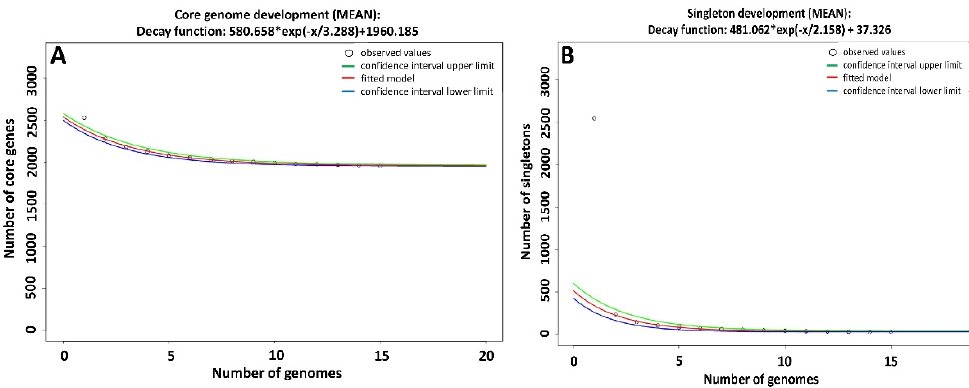
Figure 2. Singleton and Core-genome development plots calculated based on at least 15 representative D. congolensis genomes and a reference genome. It predicts that ( A ) the core genome size of D. congolensis is 1960 CDS and that, ( B ) each additional strain sequenced will add 37 new CDS to the pan-genome of D. congolensis .